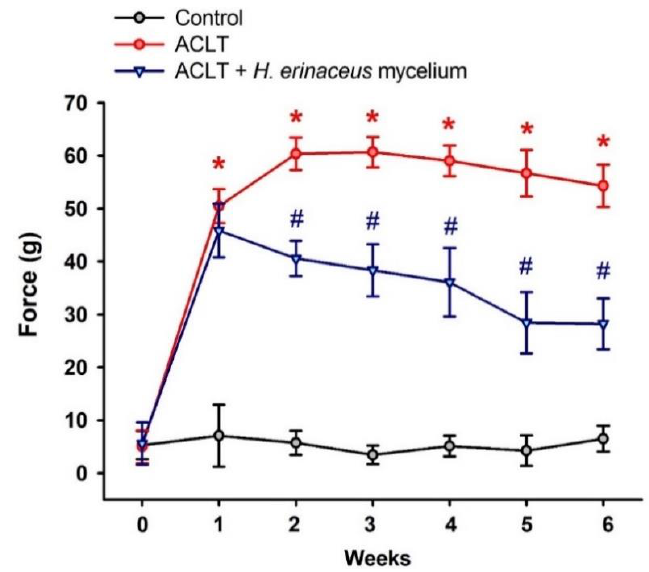
Figure 2 . H. erinaceus mycelium improves ACLT-induced weight-bearing asymmetry. Deficits in weight-bearing forces were examined every week by weight-bearing behavioral testing ( n = 6 for each group). * p < 0.05 compared to the control group; # p < 0.05 compared to the ACLT-only group.